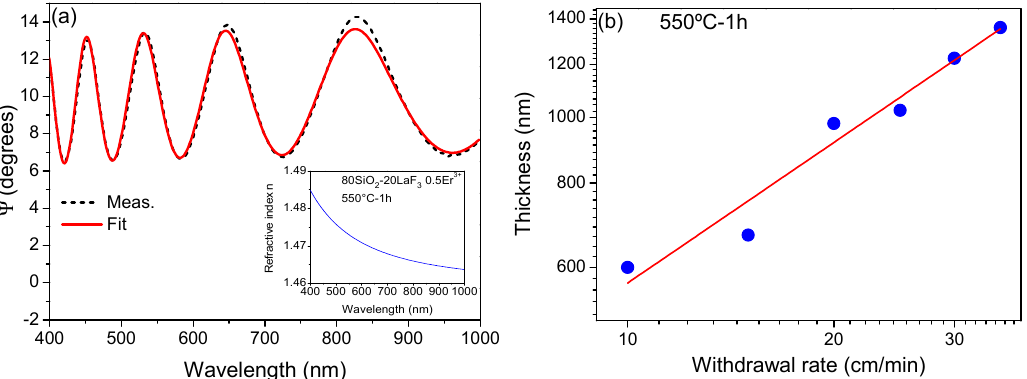
Figure 2. ( a ) Ellipsometric measurements and fit of 80SiO 2 -20LaF 3 -0.5Er 3+ (TEOS-MTES) thin film treated at 550 °C for 1 min deposited onto silica substrate using a withdrawal rate of 35 cm/min. The inset shows the dispersion relation using the Cauchy model ( b ) Variation of thickness with the withdrawal rate.